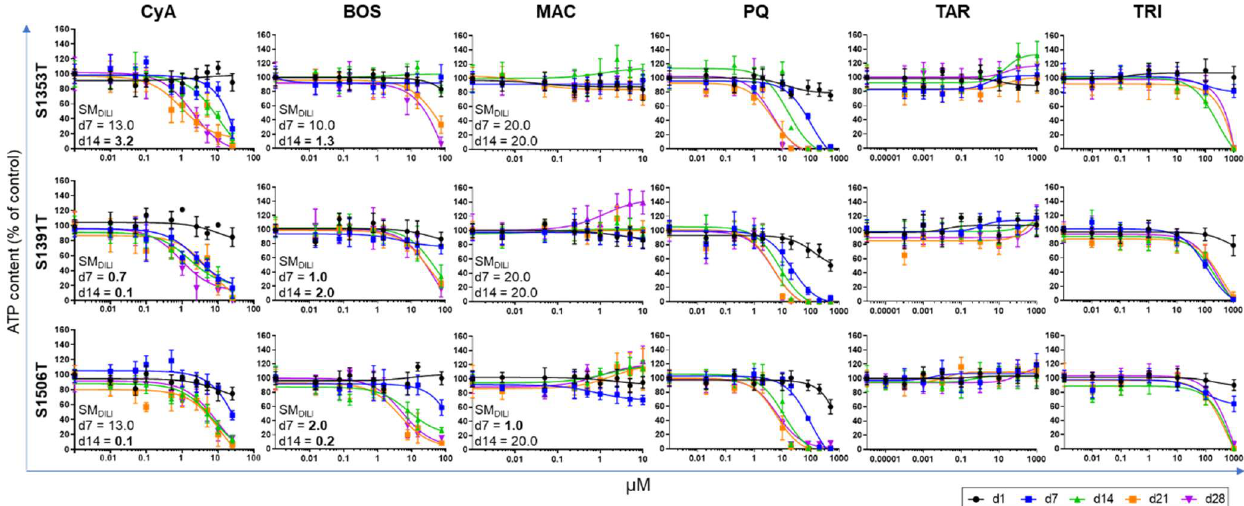
Figure 2. Cell viability of PHH spheroids after long-term repeated exposure to increasing concentrations of the test compounds. Concentration–response curves were obtained by quantifying total ATP content on days 1, 7, 14, 21 and 28 after first exposure. Concentrations were log-transformed and plotted using GraphPad Prism Software (Version 8.2.1). The DILI risk posed by the drugs was assessed by calculating the SM DILI on days 7 and 14. Results are expressed as mean ± standard deviation of at least three spheroids per donor and per time-point. ATP—adenosine triphosphate; BOS—bosentan; CIx—cholestatic index; CyA—cyclosporine-A; d—day; MAC—macitentan; PQ—paraquat; SM DILI —safety margin for drug-induced liver injury; TAR—tartrazine; TRI—triclosan.